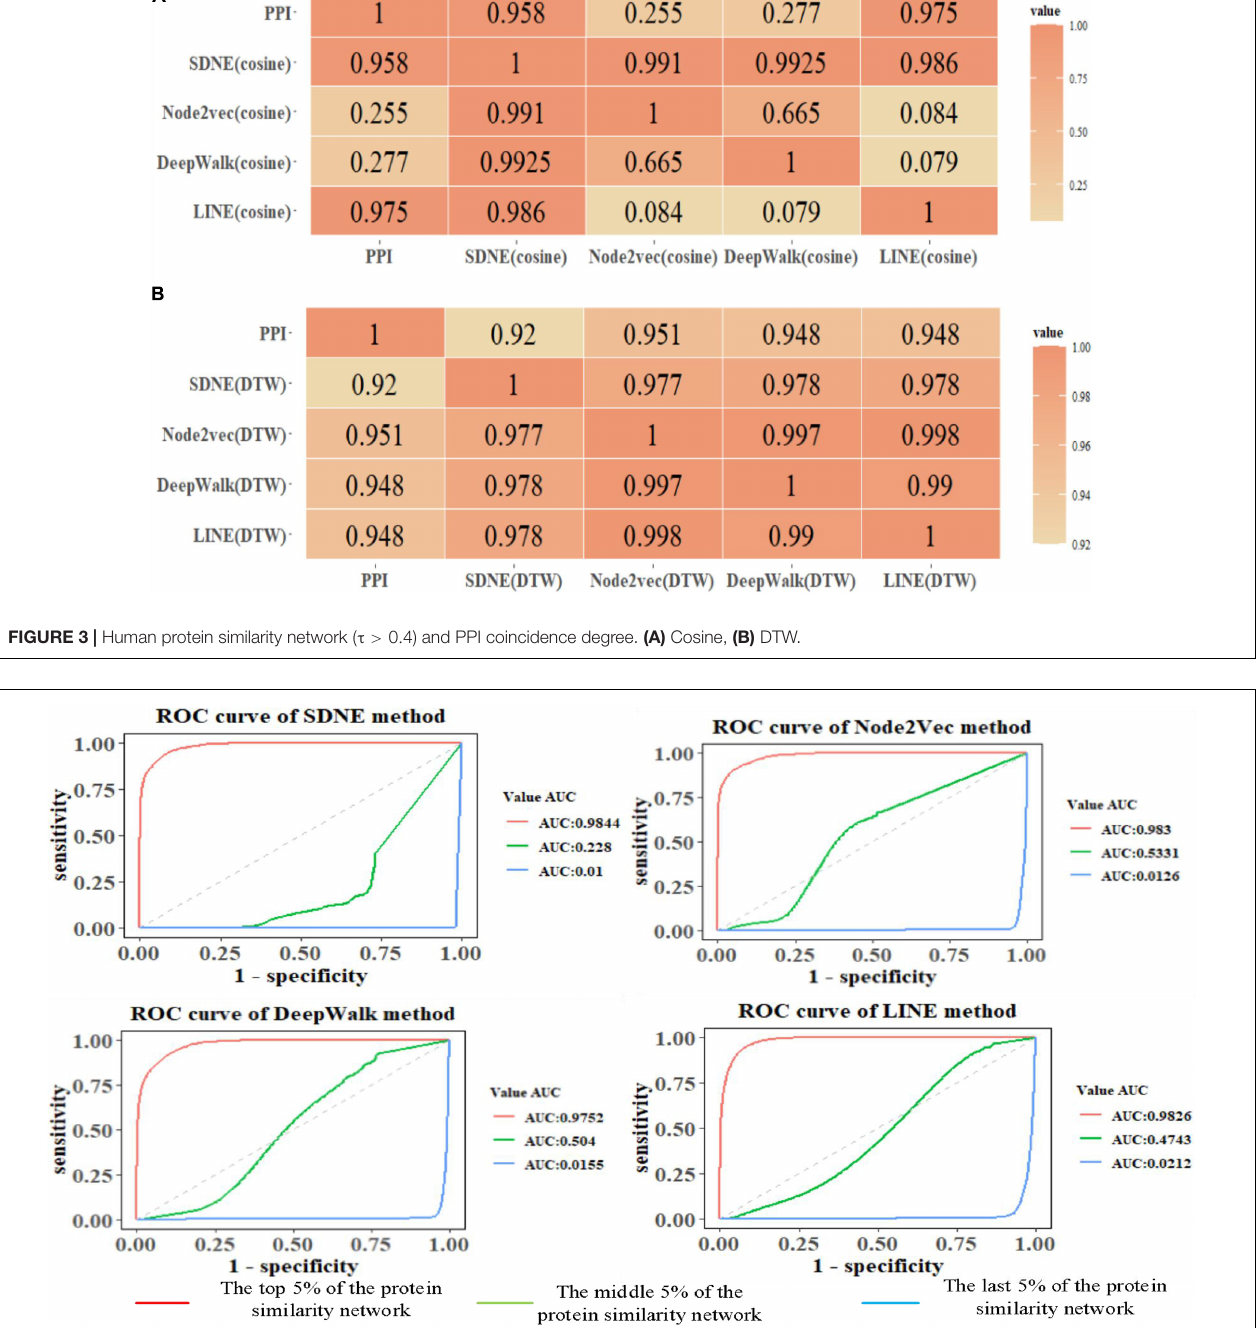
We used the DTW distance method to find a path W through several lattice points in the matrix. The shortest path is the distance between the set of vectors V m = { v 1 , v 2 , . . . v m } (cid:8) (cid:9) , v (cid:48) , . . . v (cid:48) and V n = . We then calculated the distance v (cid:48) n 1 2 used to measure the similarity between the two proteins. The